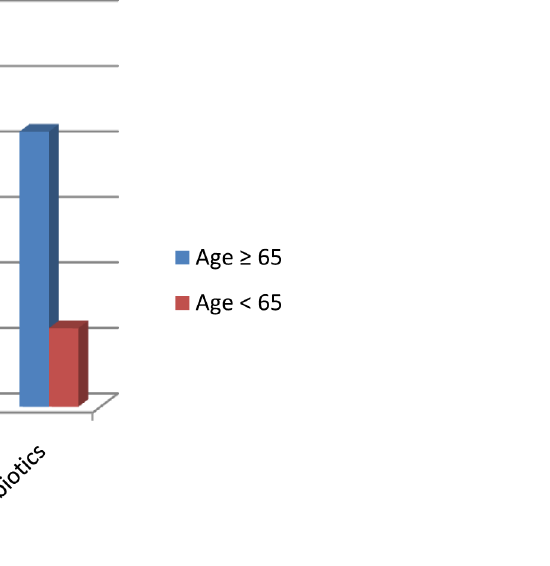
Fig 1. Comparison of antibiotic complications between age-groups (cid:1) 65 and < 65 years.